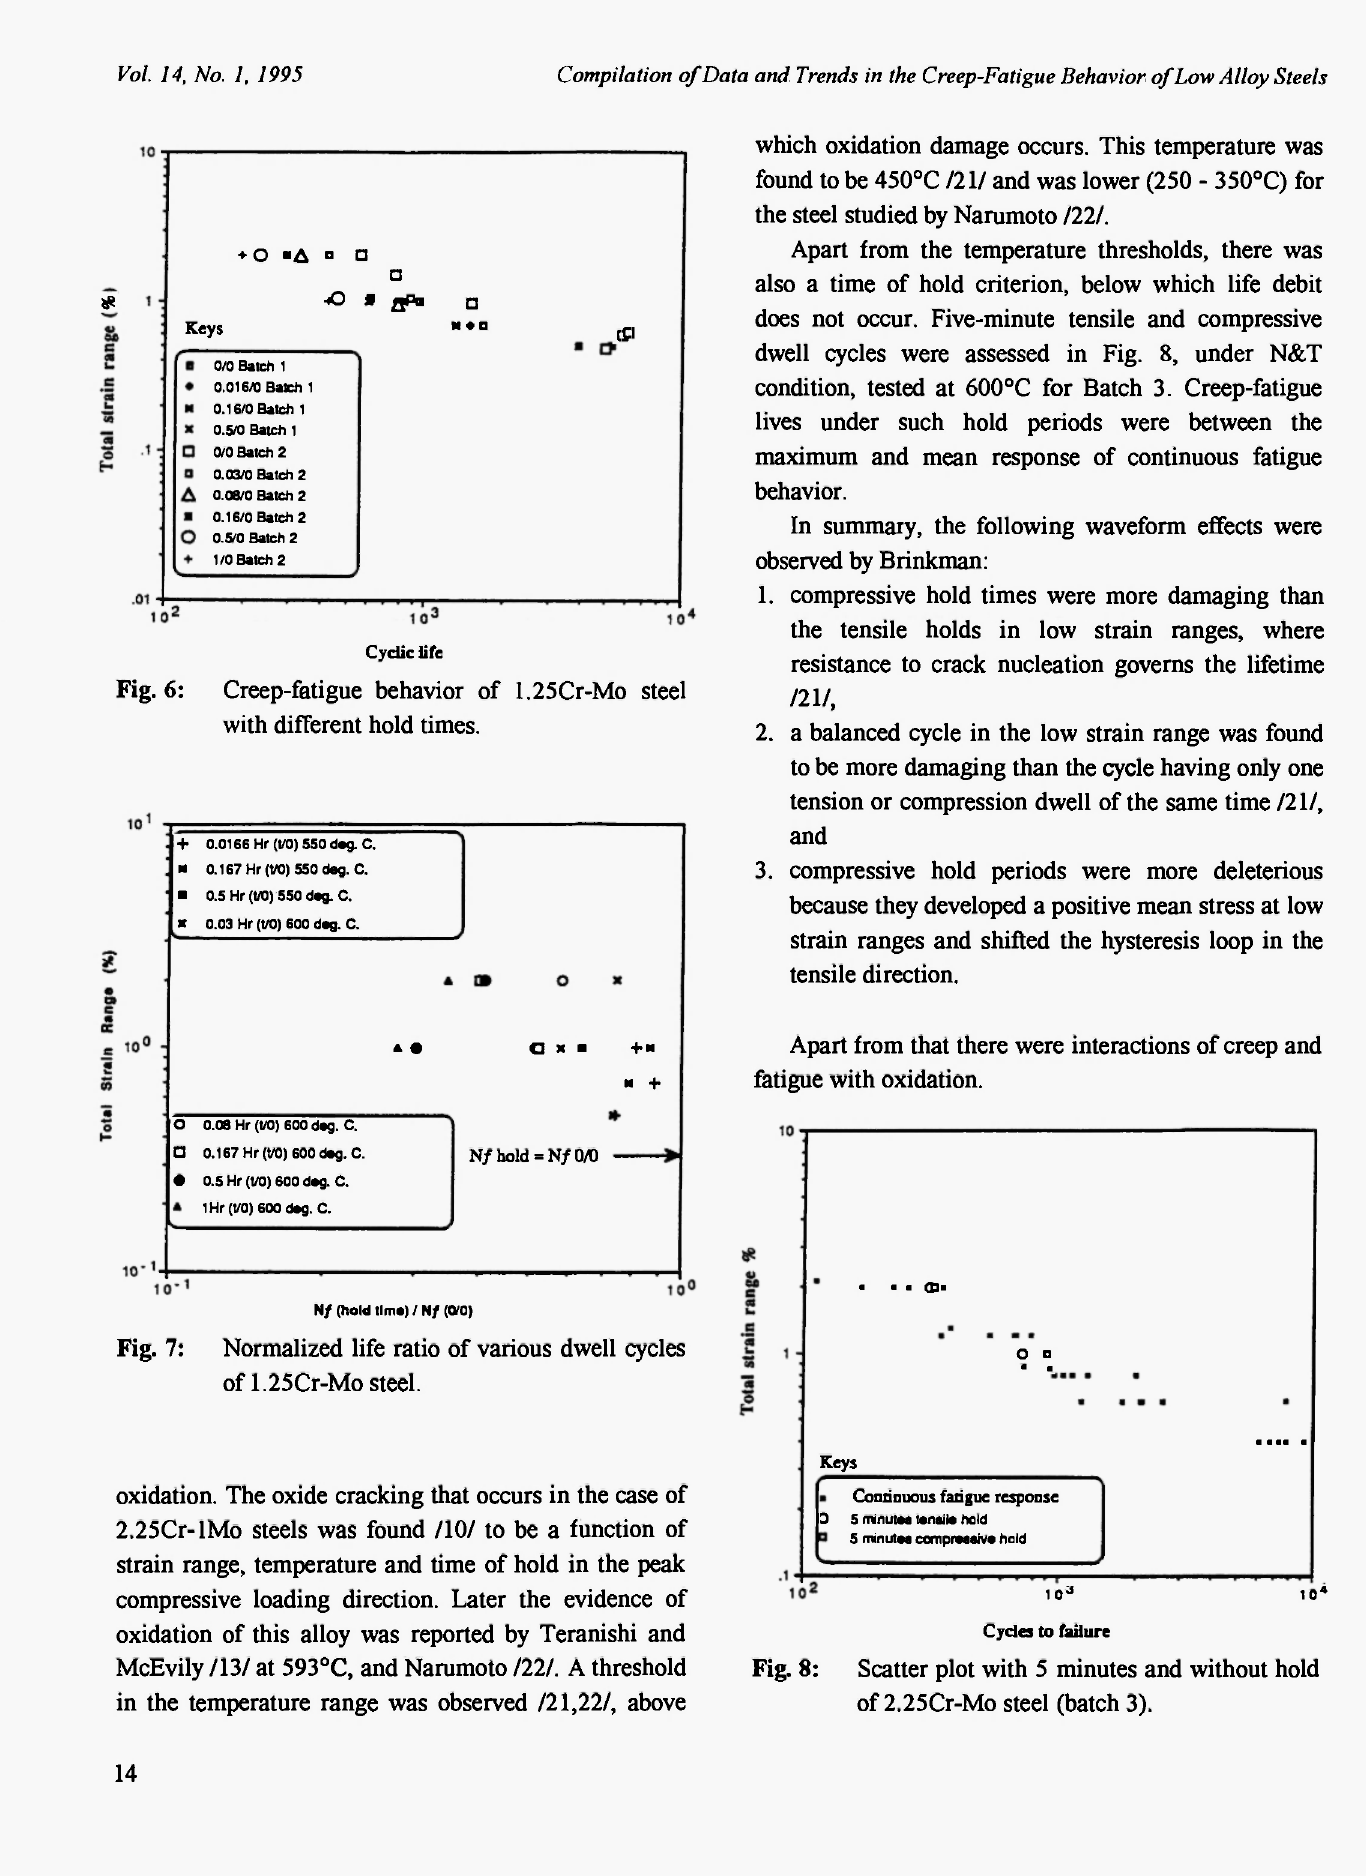
1o J to 4 Cycles to failure Fig. 8: Scatter plot with 5 minutes and without hold of 2.25Cr-Mo steel (batch